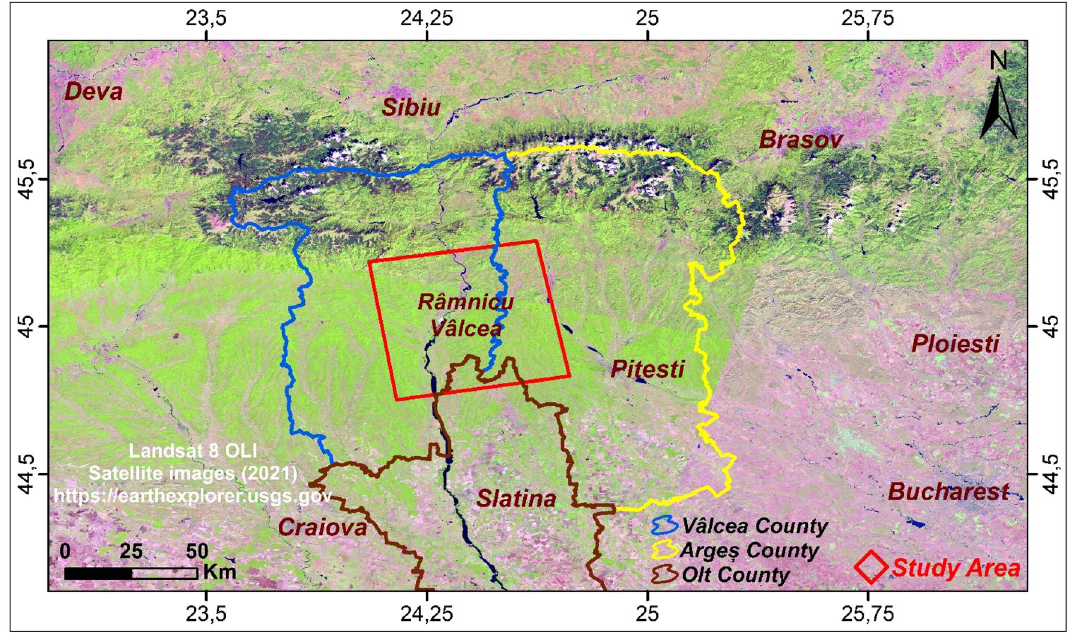
Figure 1. Geographical map generated from Landsat 8 OLI satellite images (2021) and produced using ArcGisPro 2.8.1, showing the study area (red frame) and the boundaries of the three counties, Vâlcea, Arge ș and Olt. Source: https:// earth explo rer. usgs.